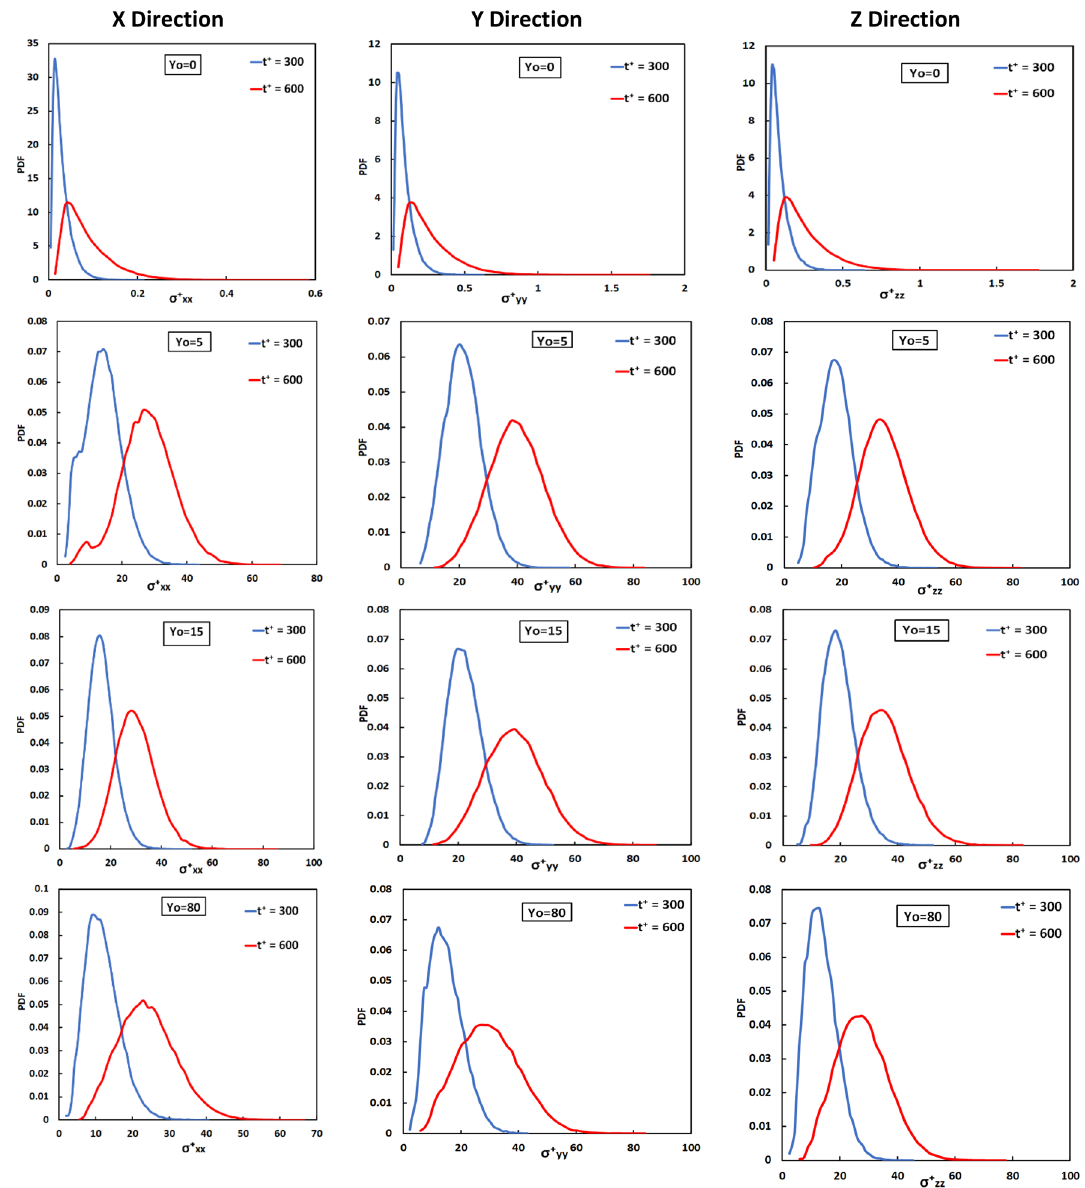
Figure 4. Probability density function of the extensional stress histories in x, y, z, directions for particles released at different positions at t + = 300 and 600 in the Poiseuille–Couette flow